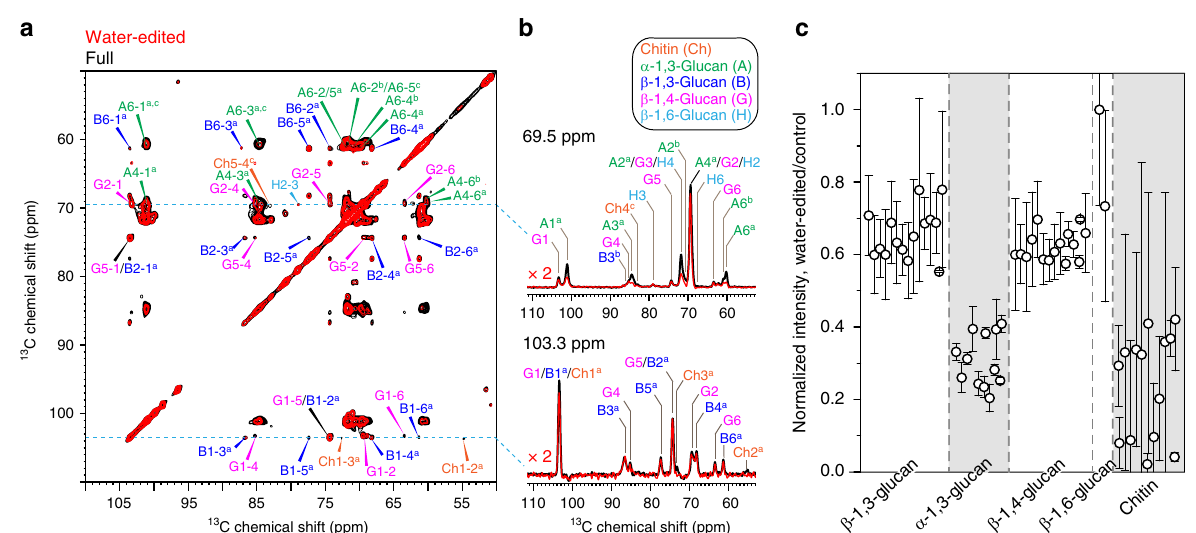
Fig. 4 Chitin and α -1,3-glucans form the hydrophobic core of A. fumigatus cell walls. a Overlay of 2D water-edited (red) and control (black) 13 C – 13 C correlation spectra and b 1D 13 C cross sections. c Relative intensities of different polysaccharides in water-edited spectra. The water-edited spectrum preferentially detects well-hydrated molecules. Error bars indicate standard deviations propagated from NMR signal-to-noise ratios. Chitin and α -1,3-glucans have the lowest intensities in water-edited spectra